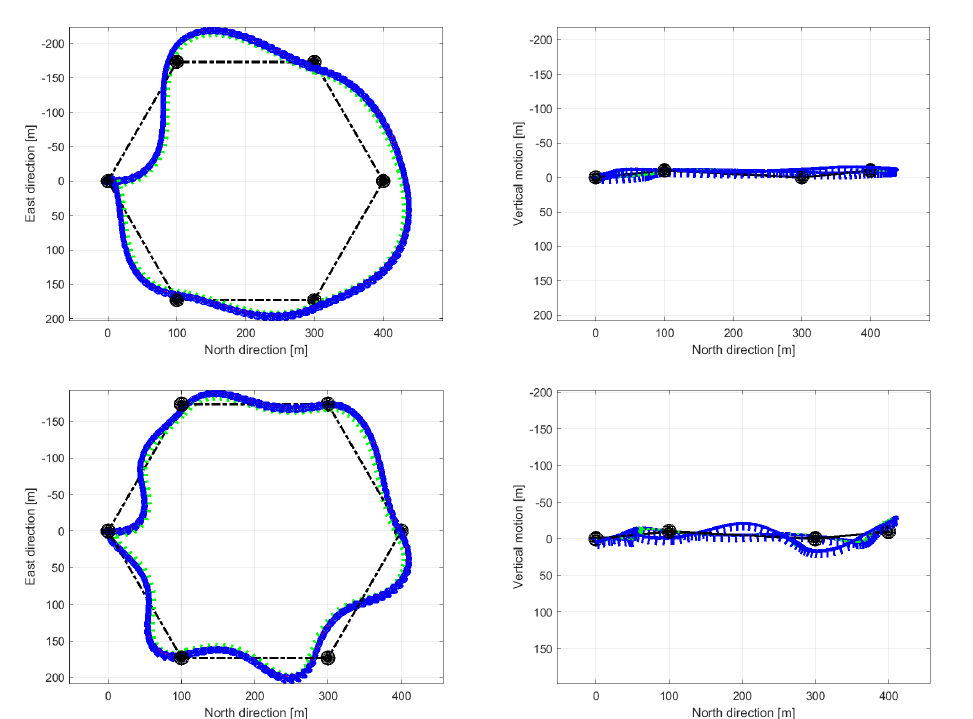
Figure 18. Trajectory views in the presence of a western wind of 3 m/s, considering the same 6-checkpoints circuit of Figures 15 and 16. Ground speed setting of 6 m/s. ( Top ) baseline airship. ( Bottom ) four-thrusters thrust-controlled airship. ( Left ) top view. ( Right ) view from the east. Black dash-dotted lines: target track. Black spheres: target checkpoint capture